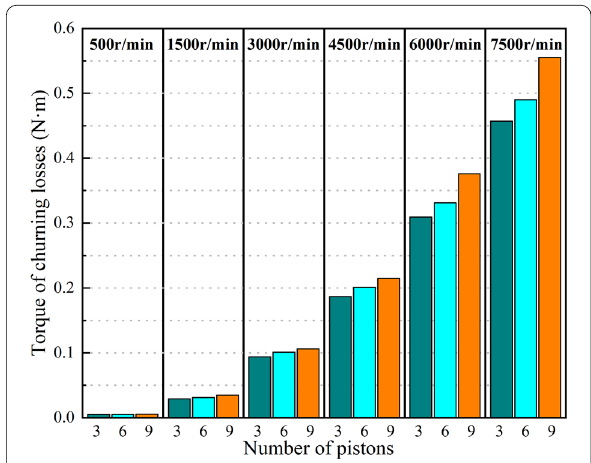
Figure 9 Simulation torque value of churning losses for different numbers of pistons without